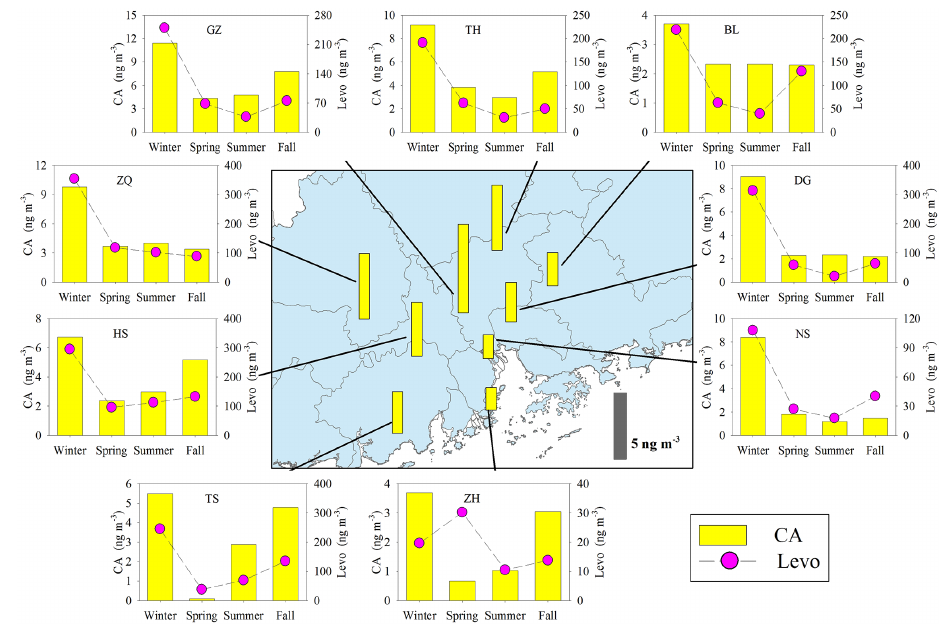
Figure 8. Spatial and seasonal variations of SOA c tracer (CA) at nine sites in the PRD. The bars in the central panel represent the annual average concentration of the SOA c tracers. The pink circle indicates the BB tracer, levoglucosan